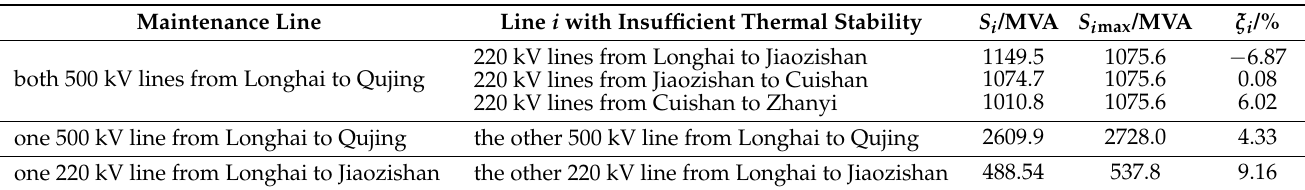
Table 2. Single maintenance conditions in which the problem of insufficient thermal stability margin of lines will occur in Qujing Power Grid.